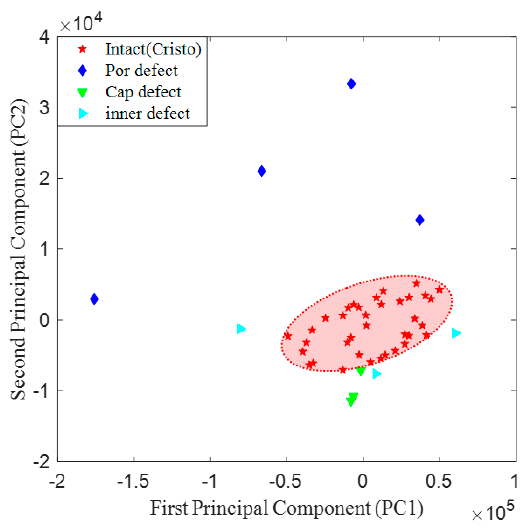
Figure 13. Two-dimensional plot using two eigenvectors extracted from frequency response data.